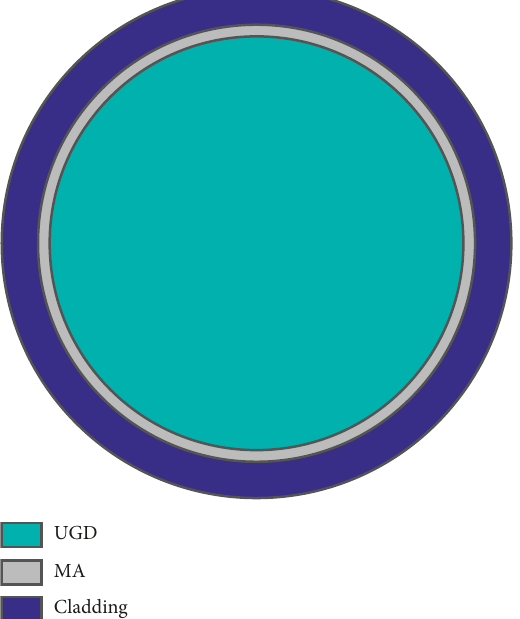
Figure 18: Coating a thin layer of MAs to the UGD pellet.